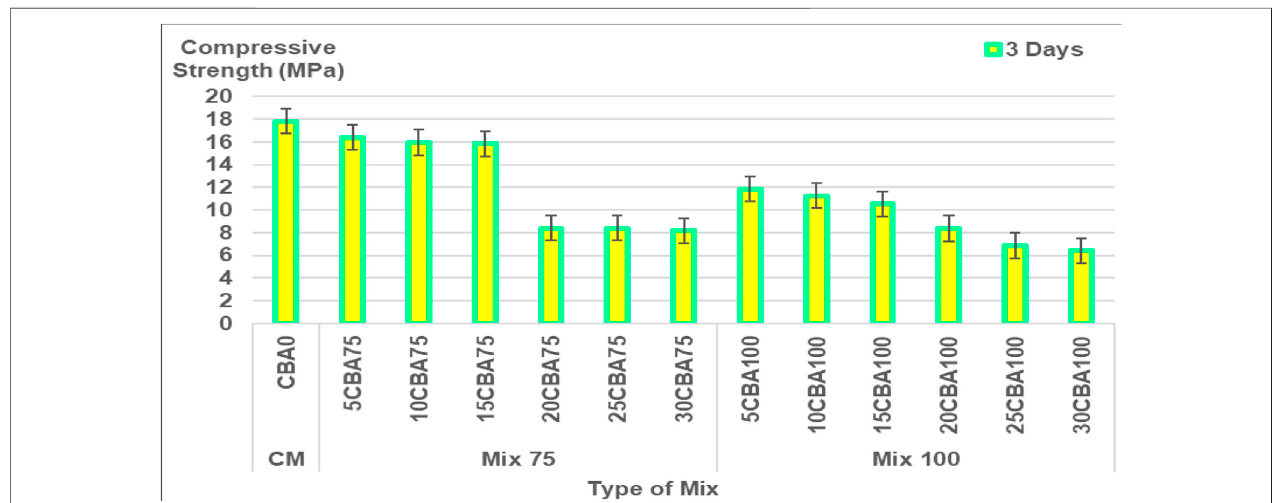
FIGURE 4 | Compressive strength (MPa) of Mix 75 and Mix 100 at 3